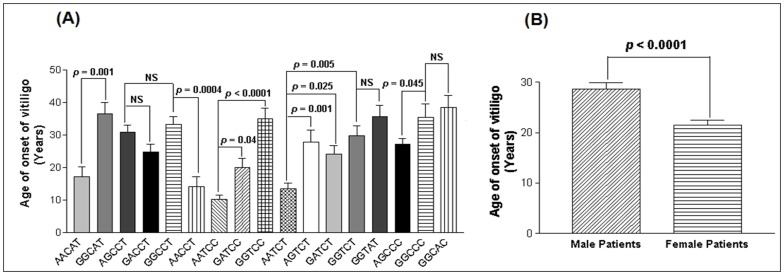
Age of onset of the disease in vitiligo patients.(A) Comparison of age of onset of the disease (years) with respect to TNF-α promoter haplotypes in 977 vitiligo patients. (B) Comparison of age of onset of the disease (years) with respect to gender differences in 451 male patients and 526 female patients with vitiligo.